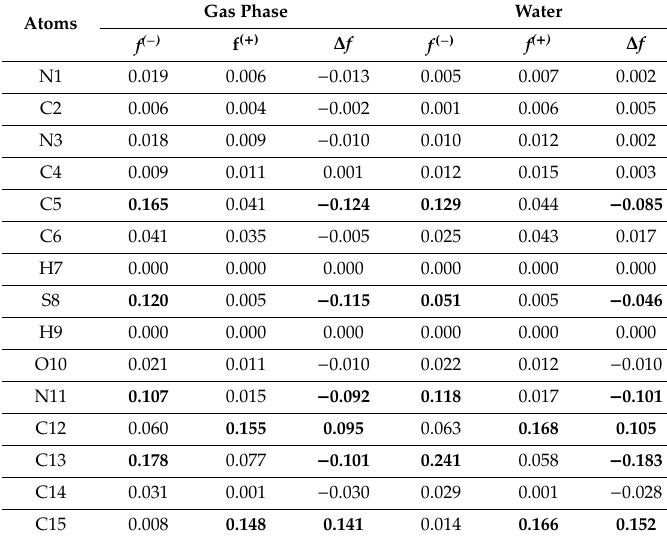
Table 5. Values of the Fukui functions and Dual descriptor of compound 1H of TUDHIPP at B3lyp / 6-311 ++ G (d,p) level of calculation in gas and aqueous phases, where bold number is the significance values in